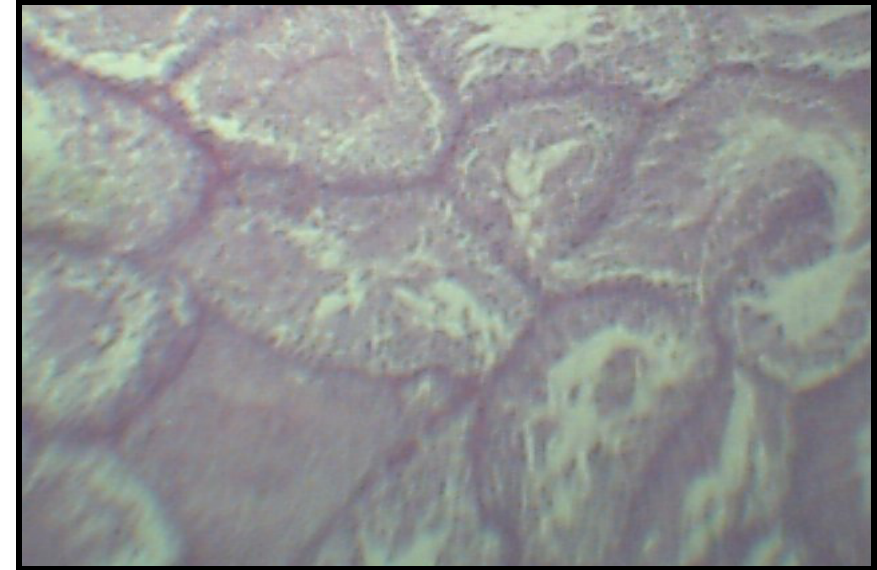
FIGURE 2 - Photomicrography of normal seminiferous tubules of an adult hamster.